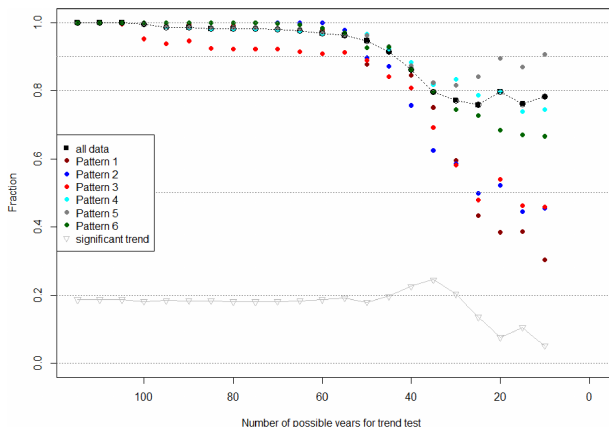
Figure 11. The fraction of stations with the same Trend Pattern as in the original full-length record for period lengths decreasing from 115 to 10 years in 5-year steps. The fraction for all data is plotted as filled black squares and for each of the six Trend Patterns as filled circles (colours are as in other figures). The fraction of stations with a significant trend for each step is plotted as gray triangles. This analysis was done using 384 sites of the original 395; the 11 sites omitted had less than 3 years’ worth of observed values in the final time period (2005–2015). Table 5. Trend Patterns for 395 stations against their Streamflow Regime Type